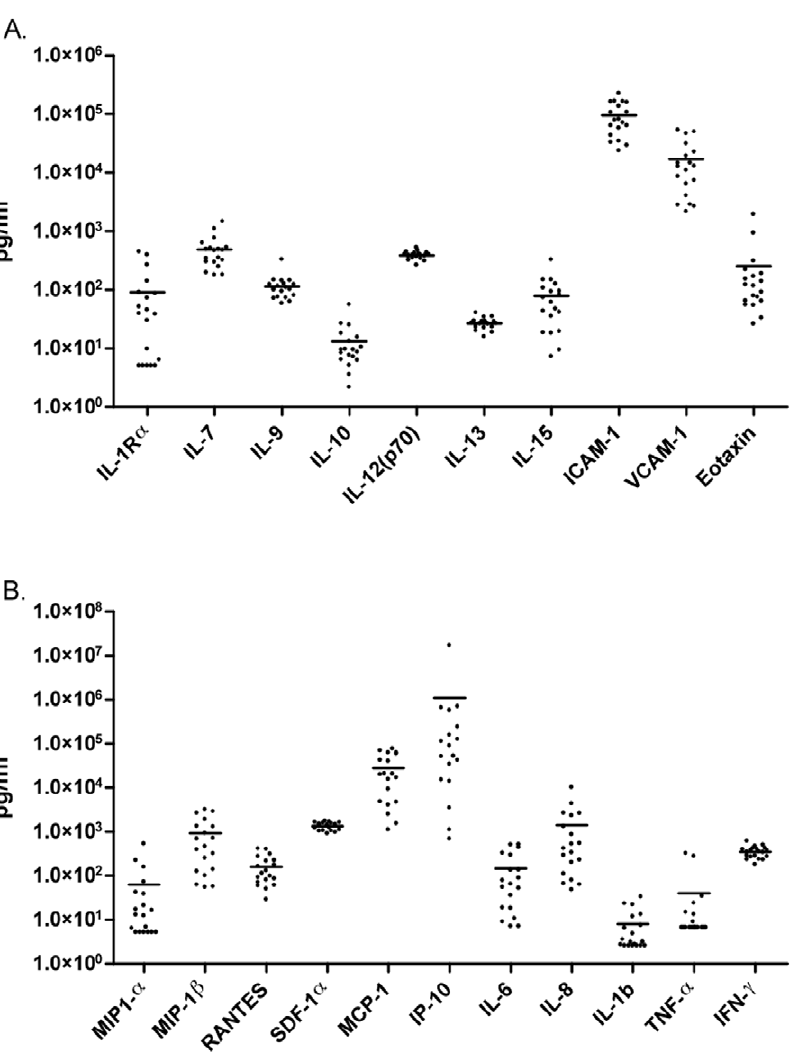
Figure 2. Immune factors in breast milk from Tanzanian donors. The concentrations of multiple immune factors including cytokines, chemokines and growth factors were measured in breast milk samples using a multiplex panel. Data for each factor is expressed as concentration (pg/mL) and is presented for all donors irrespective of HIV serostatus.